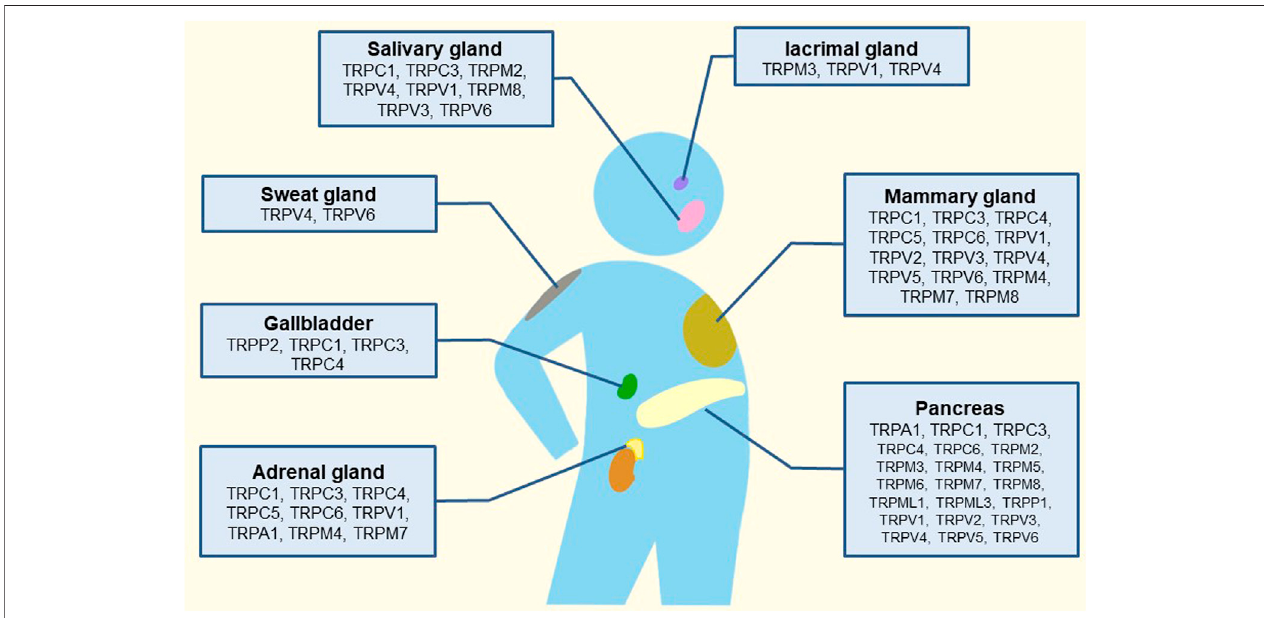
FIGURE 1 | Schematic illustration of the tissue-distribution of TRP channels and their putative roles in human glands.